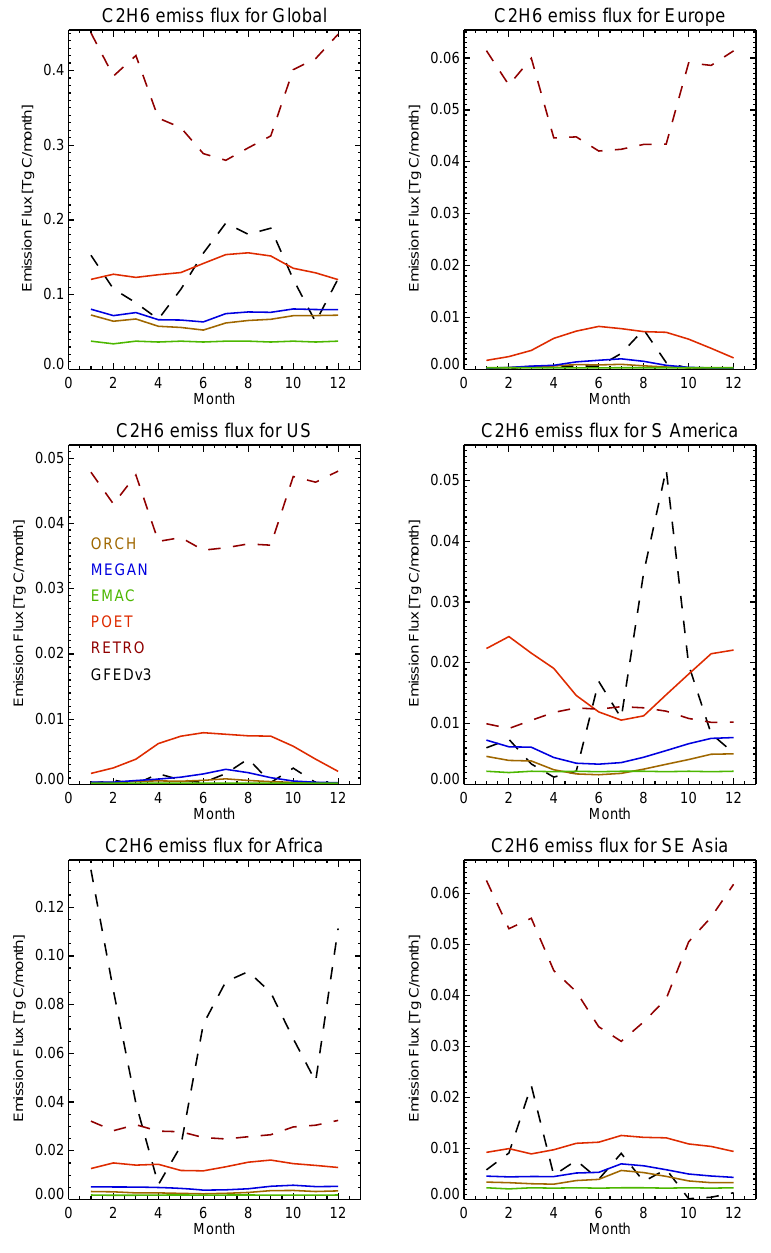
Fig. 2c. As for Fig. 2a except for C 2 H 6